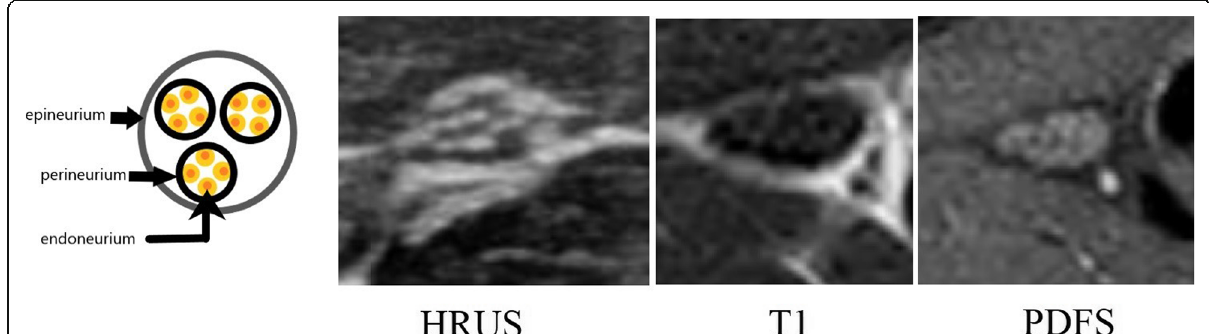
Fig. 1 Diagrammatic representation of the neuronal architecture with the neurons (orange dots) enclosed in an endoneurial sheath. The axons, Schwann cells and endoneurium are bundled together into fascicles, each of which is encompassed by a dense perineurial sheath. The epineurium is the outermost connective tissue sheath. This results in a characteristic honeycomb pattern which is identified on HRUS and MRI in transverse and axial sections respectively